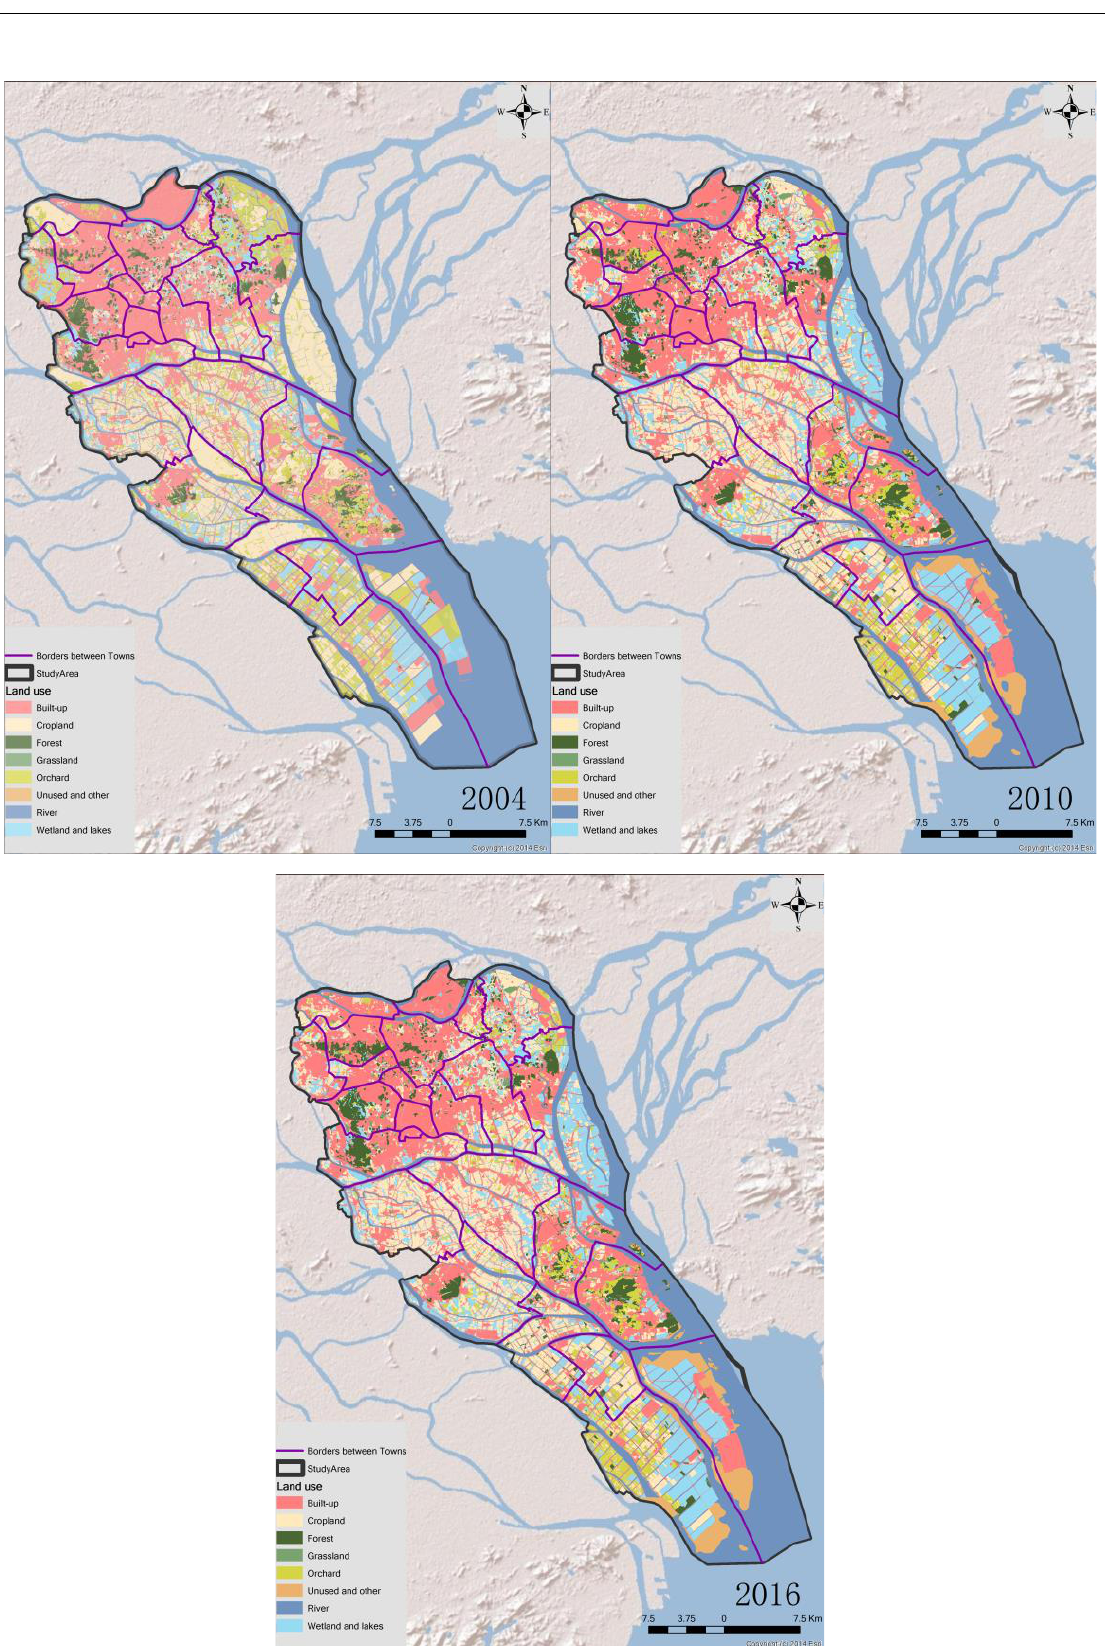
Figure 3. The special grids of the ESV (taking the 200 m scale grids as an example). 3.5. Trend Analysis for ESD Distribution Figure 4 is a graph of the 1 km × 1 km ESD global trend analysis in Figure 3. Due to the small volume of data, global trend analysis computation was performed in 1 ArcGIS Engine node in the Computing Center. Figure 4 shows that the spatial distribution of eco- system service capacity in the study area had an obvious trend effect. In the X -axis direc- tion, there was an upward trend from west to east, and the minimum value was located in the middle of the west. In the Y -axis direction, there was an upward trend from north to south, and the minimum value was in the north-central position. Due to historical rea- sons, the subcenter of Guangzhou city is located in the Panyu District in the north-western part of the study area. Many rivers, wetlands and forests with strong ecological services